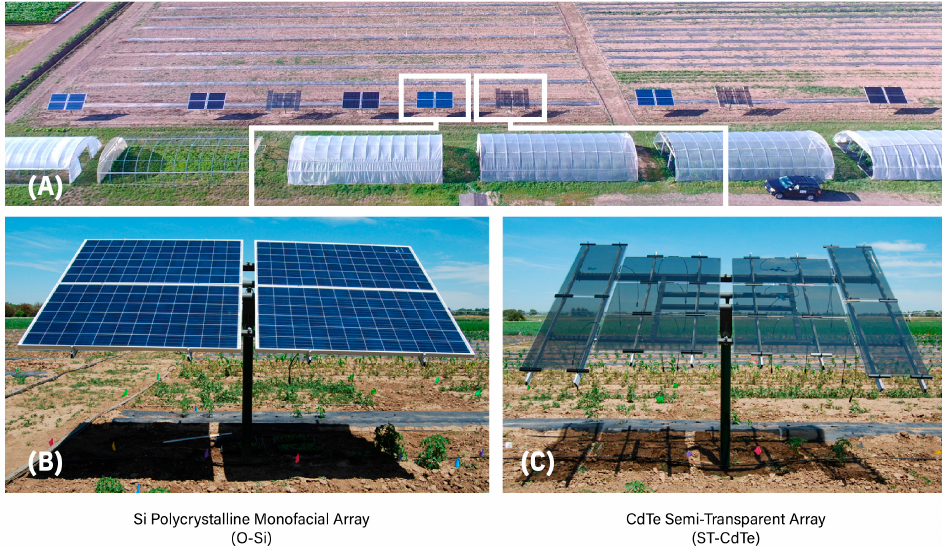
Figure 2. ARDEC site overview ( A ) Replicated AV test plots at CSU’s ARDEC South location. ( B ) Opaque silicon (O-Si). ( C ) Semi-transparent CdTe (ST-CdTe).